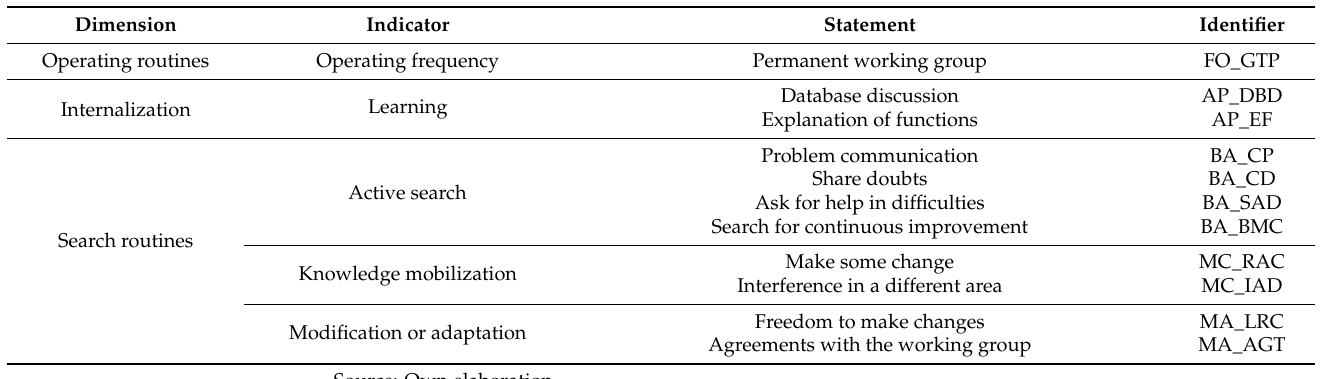
Table 8. Effects in the